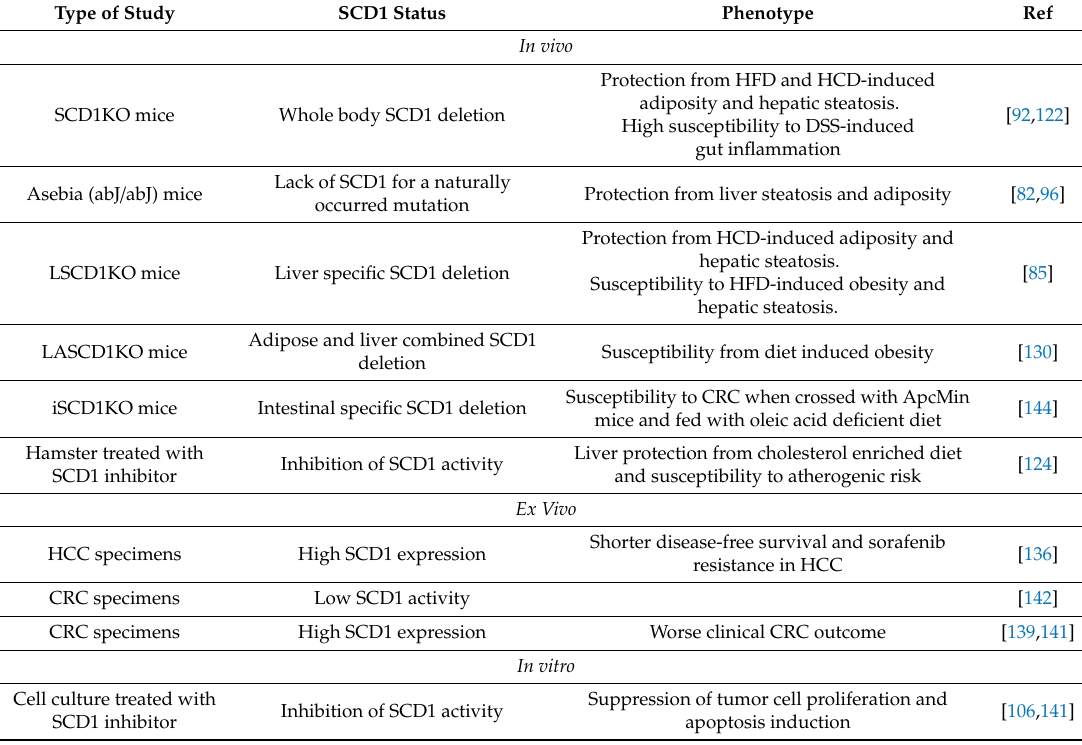
Table 3. Principal studies assessing the role of SCD1 in liver and